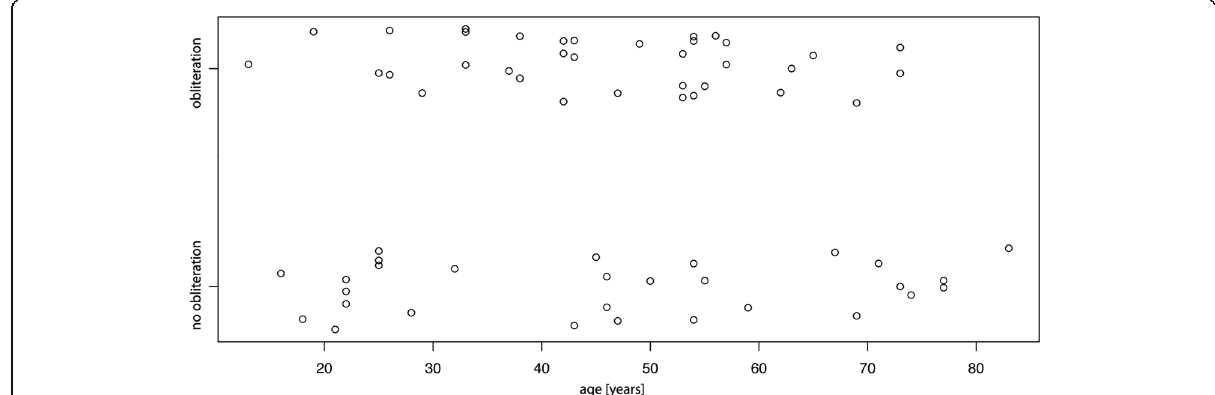
Fig. 6 No statistical significant association between a patient ’ s age and the presence of obliteration of at least one maxillary sinus was found ( p =0.92). For better visibility, the diagram has been jittered along the y -axis